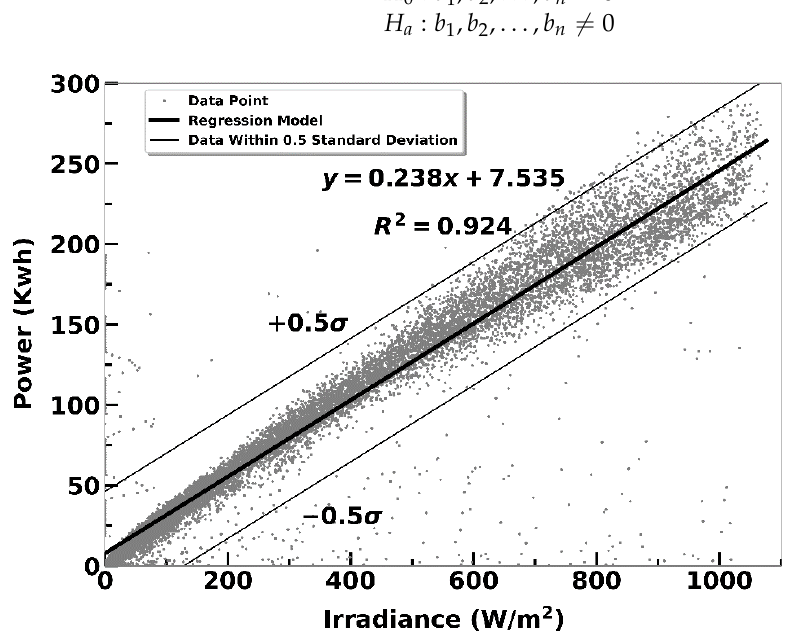
Figure 6. Two dimensions raw data of NIST photovoltaic data set — irradiance vs. power output.